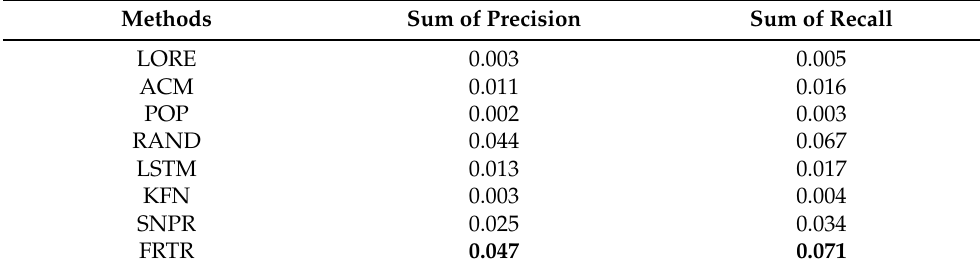
Table 8. Represents the experimental outcomes for New York, showing the cold-start issue using